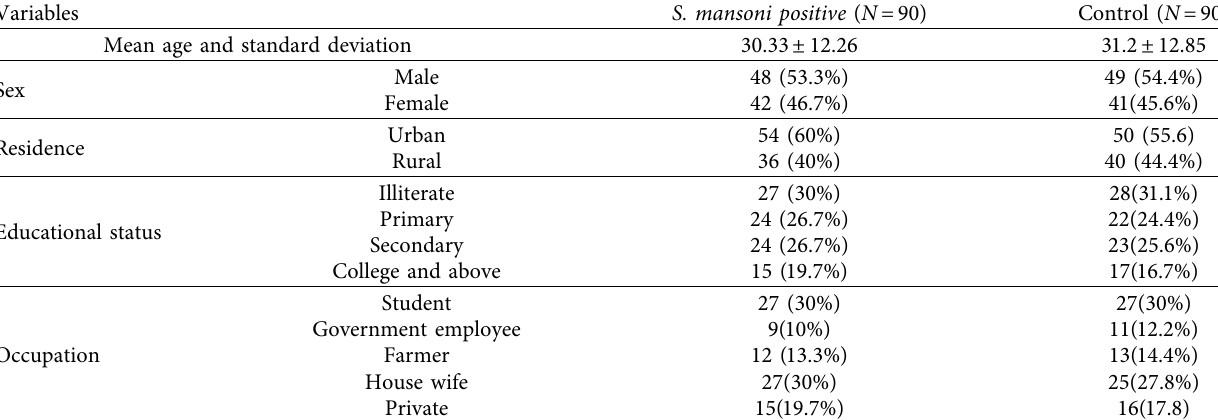
Table 1: Sociodemographic characteristics of S. mansoni -infected and noninfected study participants.